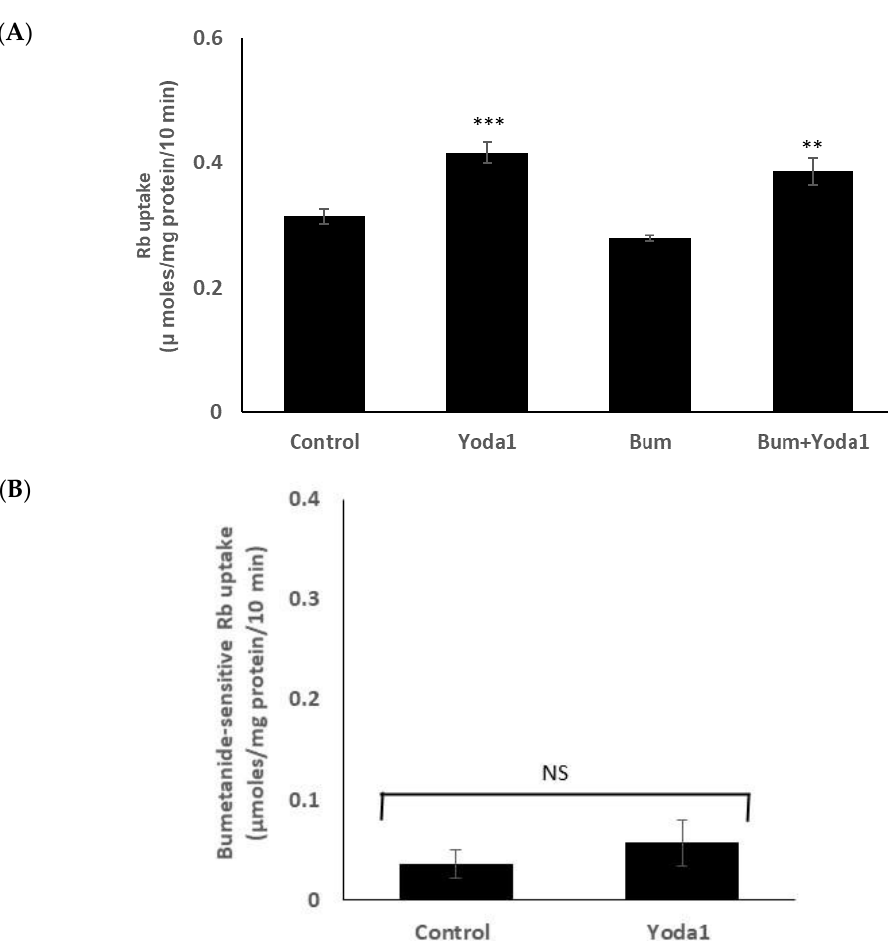
Figure 6. Yoda1 increased Rb uptake to a similar degree in the presence or absence (control) of the NKCC inhibitor bumetanide (1 µ M). ( Panel A ) shows Rb uptake in cells exposed to Yoda1 (1 µ M) in Rb-containing Krebs solution ± bumetanide for 10 min. Added alone, bumetanide slightly reduced Rb uptake, but not to a significant degree. ( Panel B ) shows the bumetanide-sensitive component of Rb uptake. The values are the mean ± SEM of results from 6 independent experiments. ** and *** indicate significant differences ( p < 0.01 and p < 0.001, respectively) from the control (no Yoda1), as determined by one-way ANOVA followed by Š í d á k’s multiple comparison test. NS = not significant.